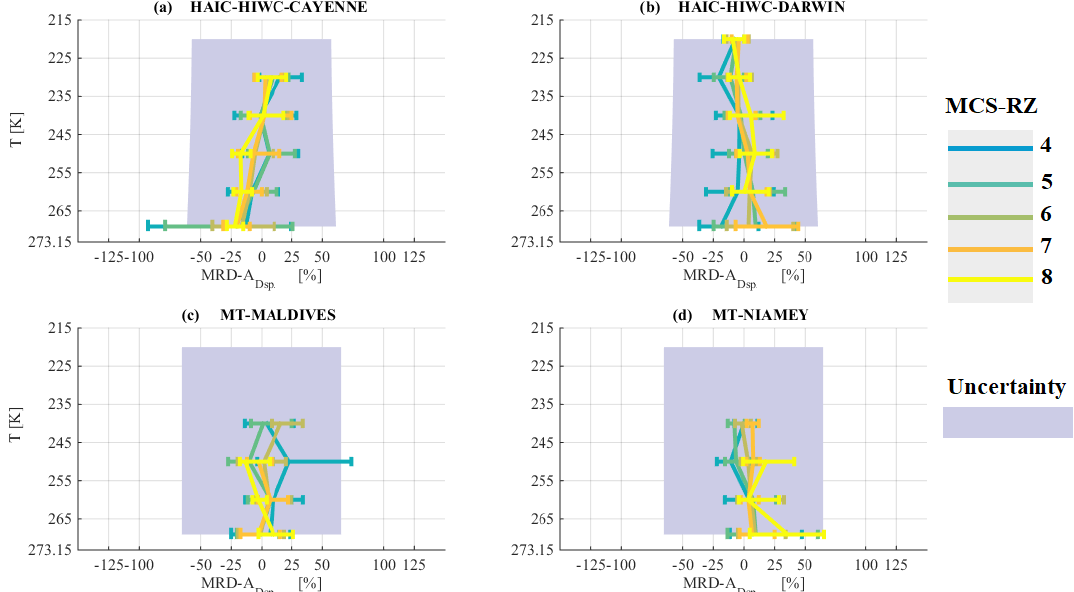
Figure E6. The same as Fig. 6 but for the ratio MRD- A Dsp , where PSD is used as a function of equivalent spherical diameter.